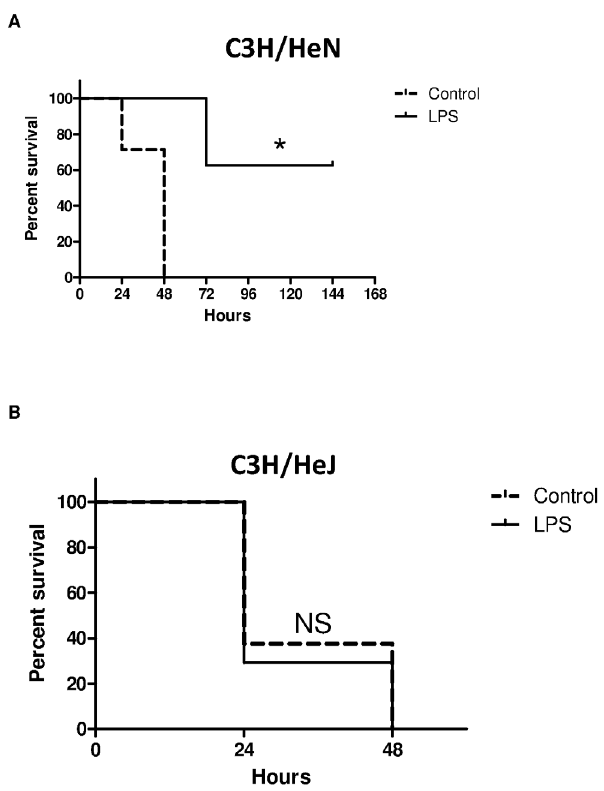
Figure 5. Survival curves for (A) C3H/HeN (N=8) and (B) TLR4- deficient C3H/HeJ (N=17) mice challenged with S.pneumoniae after pretreatment with LPS compared to PBS treated controls, *log-rank test, p ,